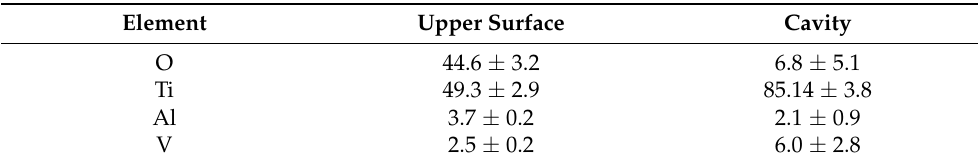
Table 2. EDXS analyses results in %wt. performed on different sites on the surface of anodized specimens at 60 V for 120